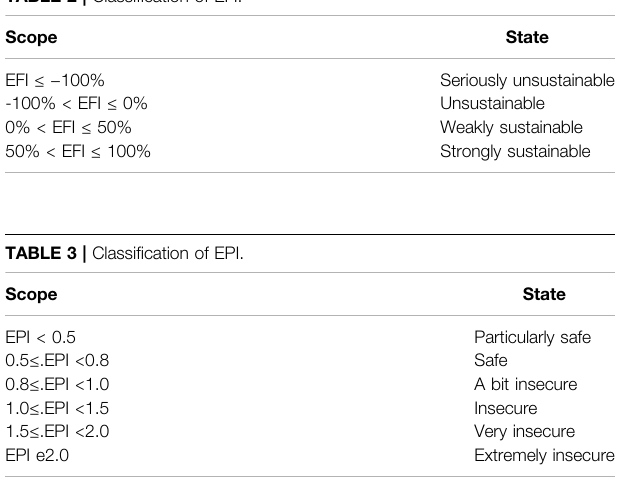
TABLE 2 | Classi fi cation of EFI.